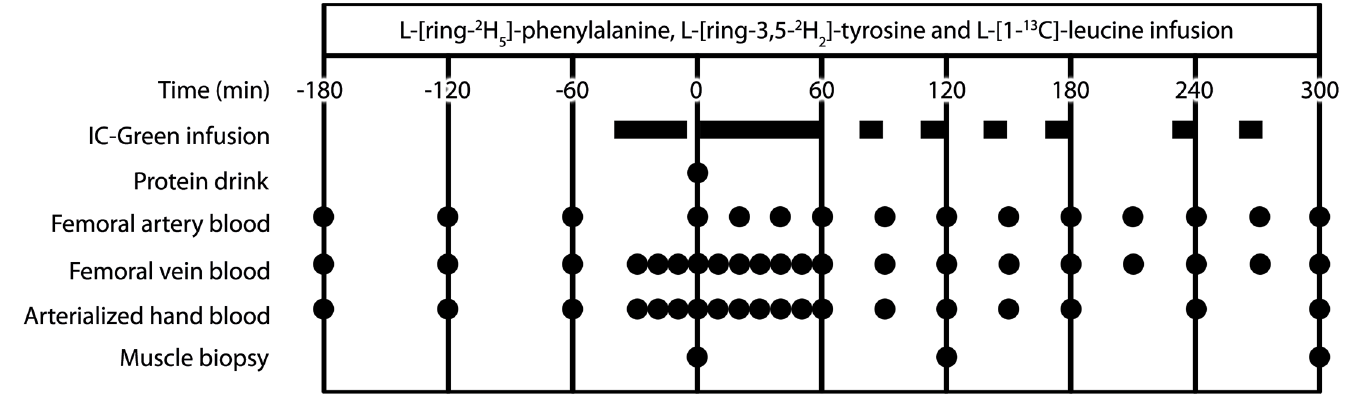
Fig 2. Outline of study protocol.